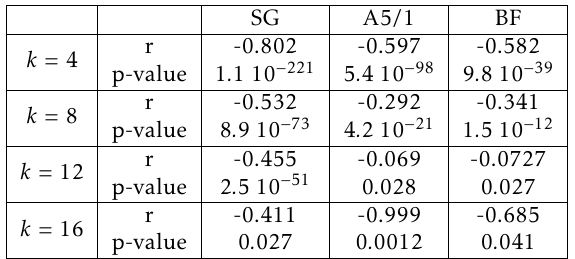
Table 3. Pearson’s p -test results for Hadamard values and entropy correlation